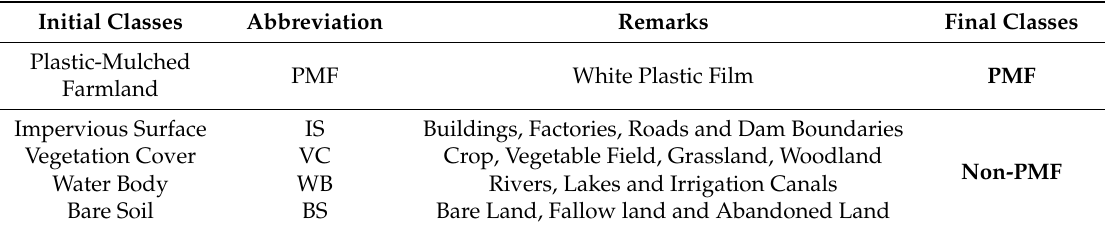
Table 1. The land cover classification